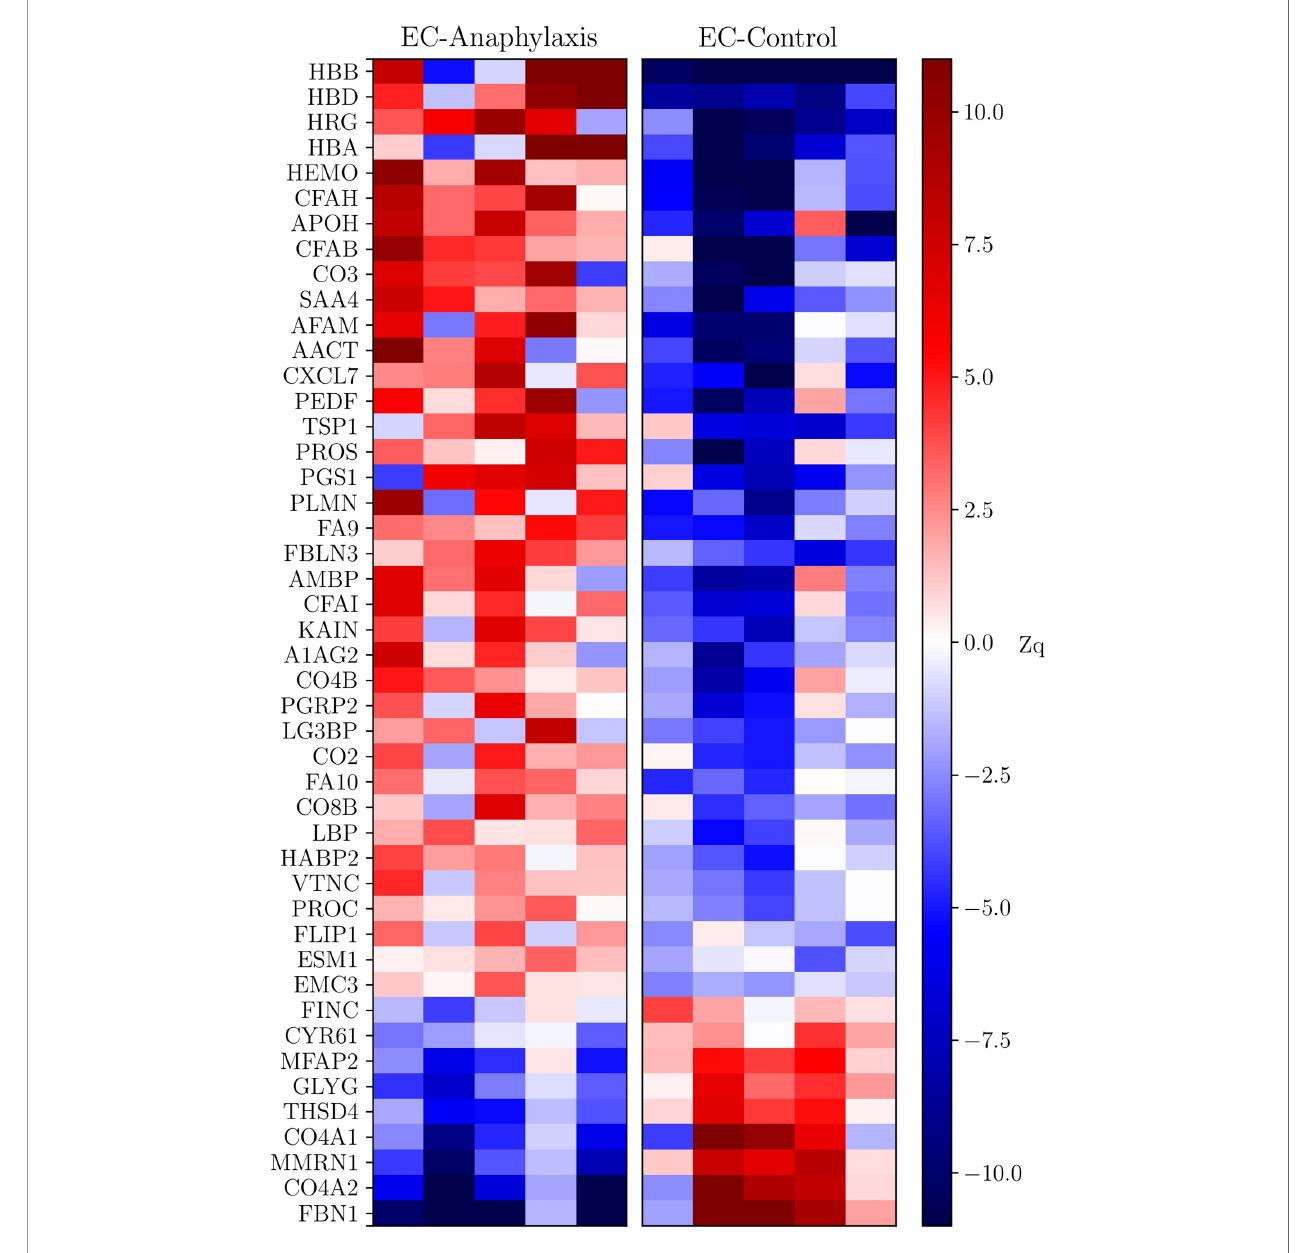
FIGURE 4 | Heatmap of the data set of proteins selected in EC-anaphylaxis and EC-control systems. The y-axis corresponds to the statistically signi fi cant proteins and the x-axis to the mean abundance ( D Zq) in the samples from the EC-anaphylaxis group on the left and from the EC-control group on the right. According to the color scale on the right, increased proteins are indicated in red and decreased proteins in